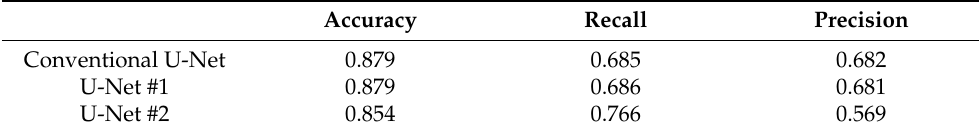
Table 3. Accuracy, recall, and precision (image with large number of particles).